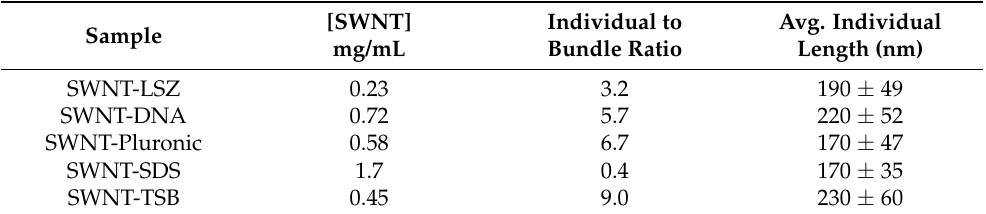
Table 2. SWNT concentrations, individual-to-bundled SWNT ratio, and average length of individual SWNT for each